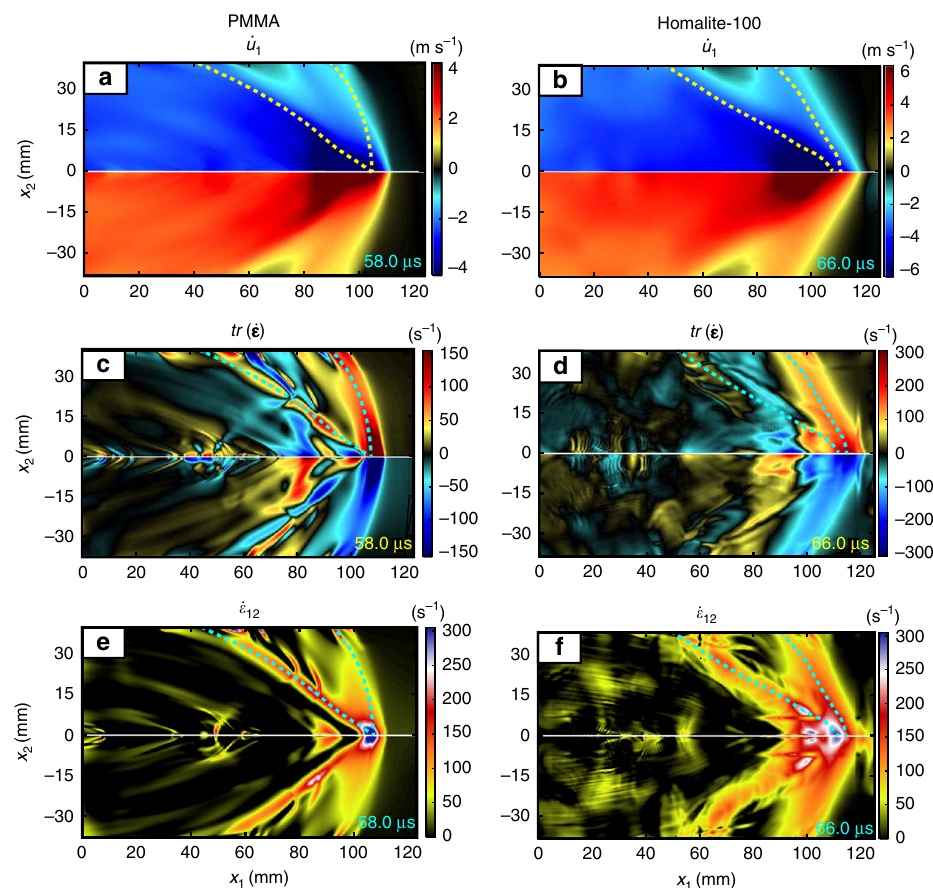
Fig. 2 Full- fi eld particle velocities and strain measures for supersonic ruptures. Ruptures in both PMMA (left) and Homalite-100 (right) exhibit two pairs of shock fronts, the pressure and the shear one (colored dashed lines). The PMMA snapshots correspond to 58 μ s after the triggering and the Homalite-100 ones to 66 μ s. a , b Interface-parallel particle velocity, _ u 1 . c , d Volumetric strain rate, tr _ ε ð Þ (see Supplementary Movie 1 on the temporal evolution of the volumetric strain rate in PMMA). e , f Shear strain rate, _ ε 12 . The volumetric strain-rate fi eld ( c and d ) clearly shows the presence of the pressure shock front, whereas the shear strain-rate fi eld ( e and f ) highlights the shear shock front. The pressure and shear shock fronts, highlighted by dashed lines, are traced as the loci of maxima of the volumetric strain rate ( c , d ) and shear strain rate ( e , f ),